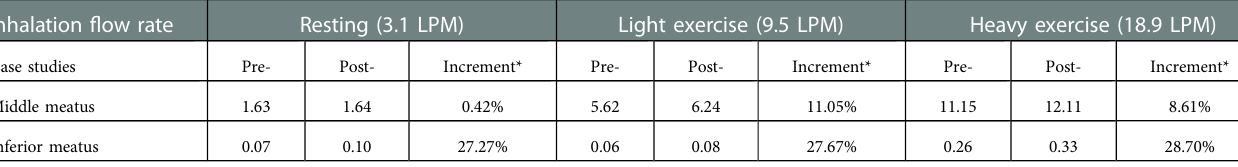
TABLE 2 Comparison of local fl ow distribution* in the middle and inferior meatus between pre- and post-virtual surgery subjects. Inhalation fl ow